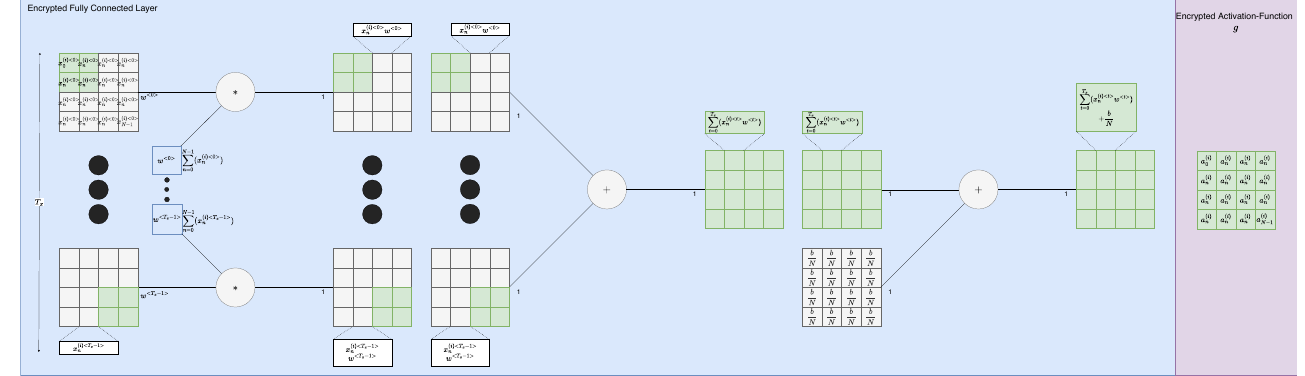
Figure 7. Encryptedvariant of an ANN/dense neural network, usually used in our case to merge divergent times/branches/filters back together into a single output. Symbol ‘ ∗ ’ denotes element-wise multiplication. Please see our documentation for closer detail